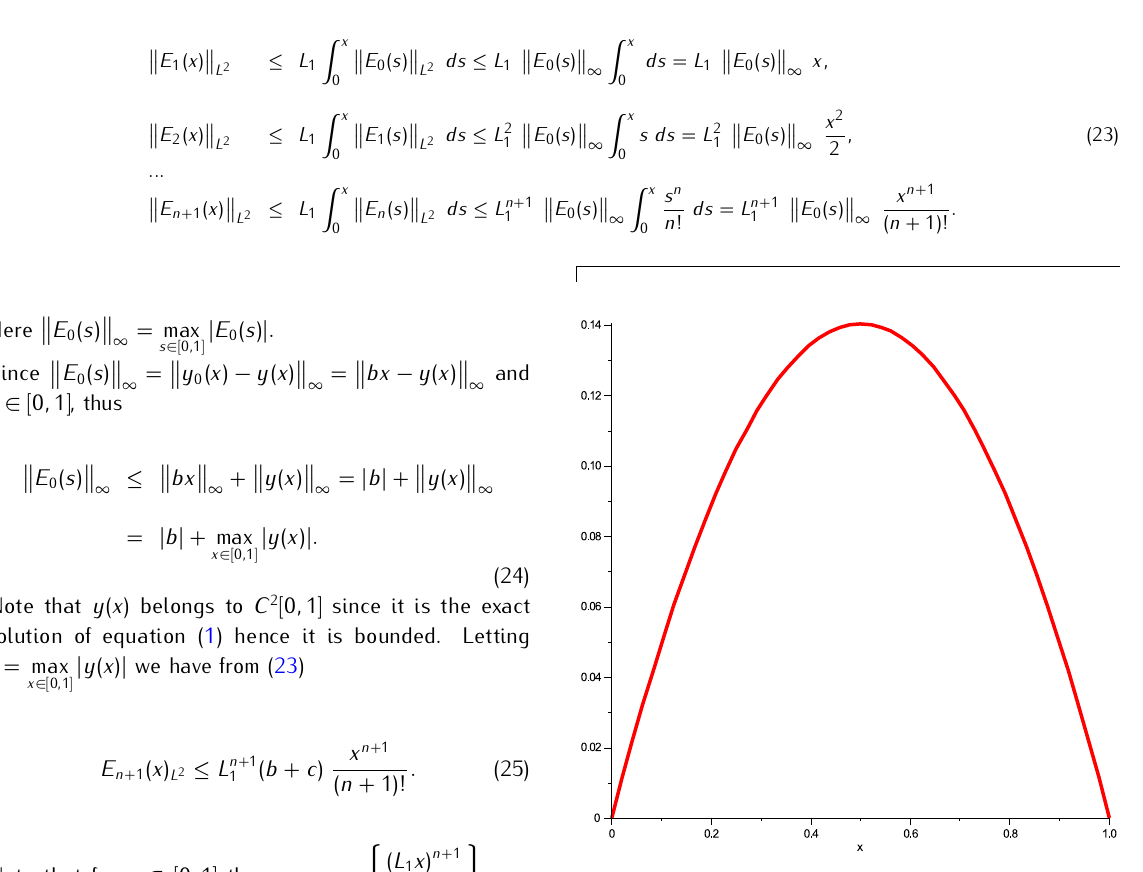
Figure 1. Numerical solution of Bratu’s problem for the case λ = 1.